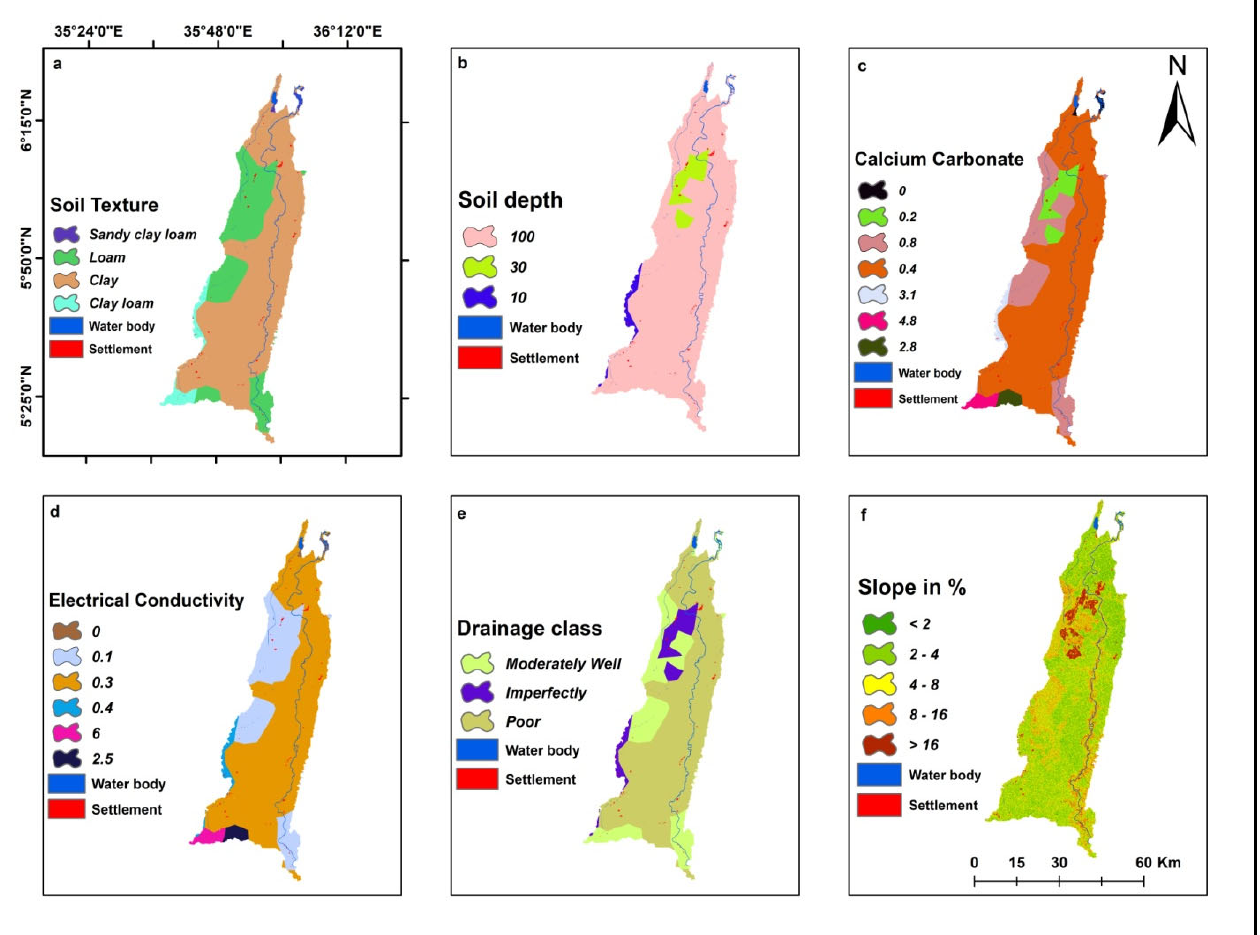
Figure 5. Topography and soil physical and chemical properties of the study area: ( a ) Soil texture, ( b ) Soil Depth (cm), ( c ) Calcium Carbonate (CaCO 3 ) (%), ( d ) Electrical Conductivity (dS m − 1 ), ( e ) Drainage class, and ( f ) Slope (%).